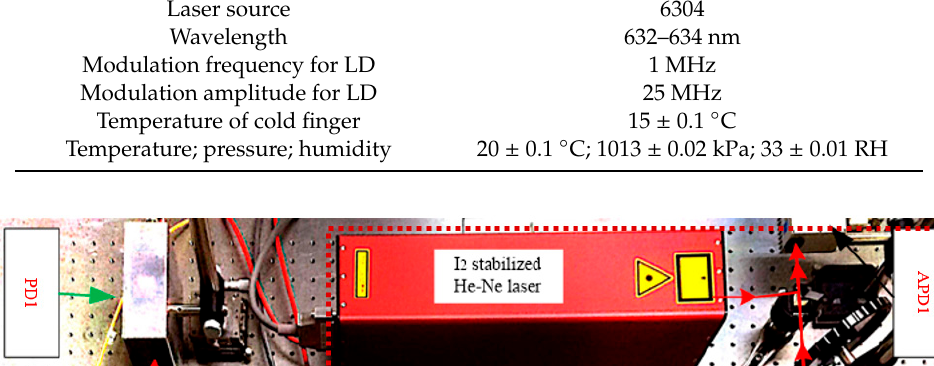
Figure 4. Hyperfine spectrum of the transition 6–3, P(33) of 127 I 2 obtained by third-harmonic detection with a modulation frequency of 1 MHz: ( a ) a modulation excursion of 10 MHz; ( b ) a modulation excursion of 15 MHz; ( c ) a modulation excursion of 20 MHz; ( d ) a modulation excursion of 25 MHz.